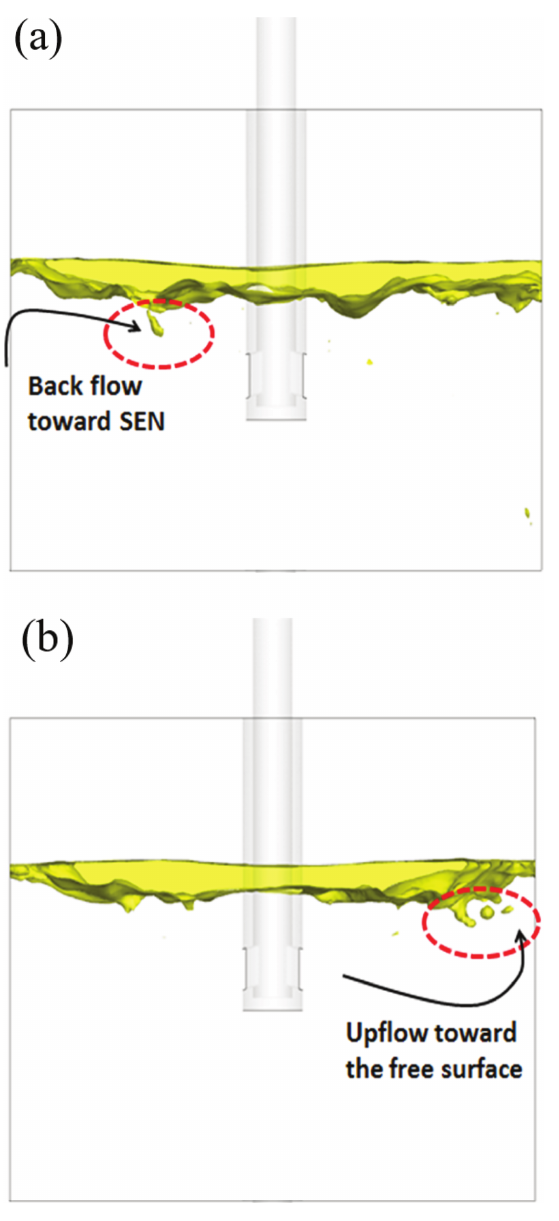
Figure 8: The two main ways of the slag entrainment in the simula- tion: (a) horizontal back-flow toward the SEN and upper-flow toward the free surface.